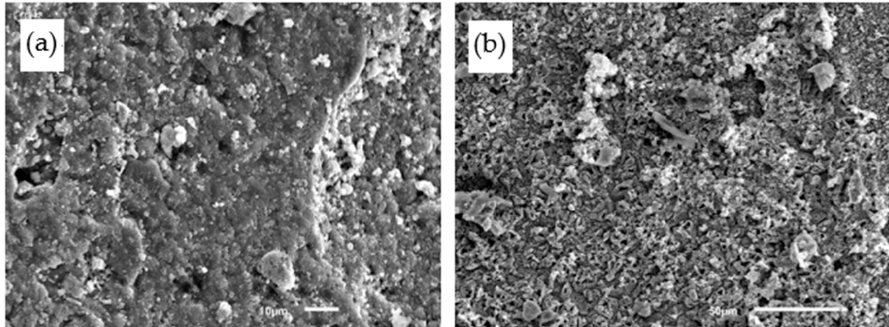
Figure 13. Microstructures of 8% FAG PCPC. ( a ) Without wet-dry cycle and ( b ) with 12 wet-dry cycles in acid rain solution.